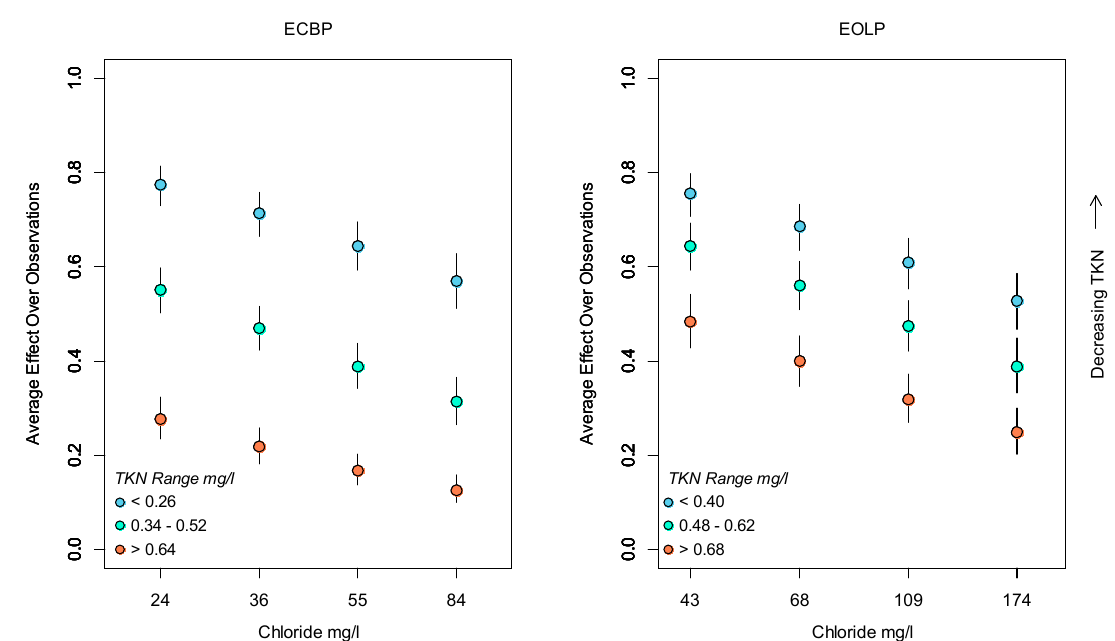
Figure 9. Probabilities of observing macroinvertebrate communities meeting their ecoregion benchmark given relevant levels of chloride and observations of covariates within three data slices defined by quantile levels of TKN (lower, middle and upper 25th quantiles). The chloride levels were obtained by sequencing the range from the 25th to 90th percentiles (in log space). Examples are for the Eastern Corn Belt Plains (ECBP) and Erie-Ontario Lake Plain (EOLP).